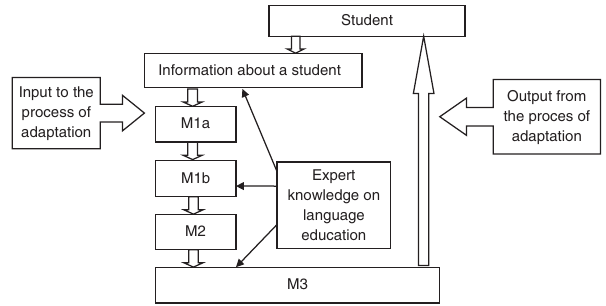
Figure 1: Scheme of the Decision-Making